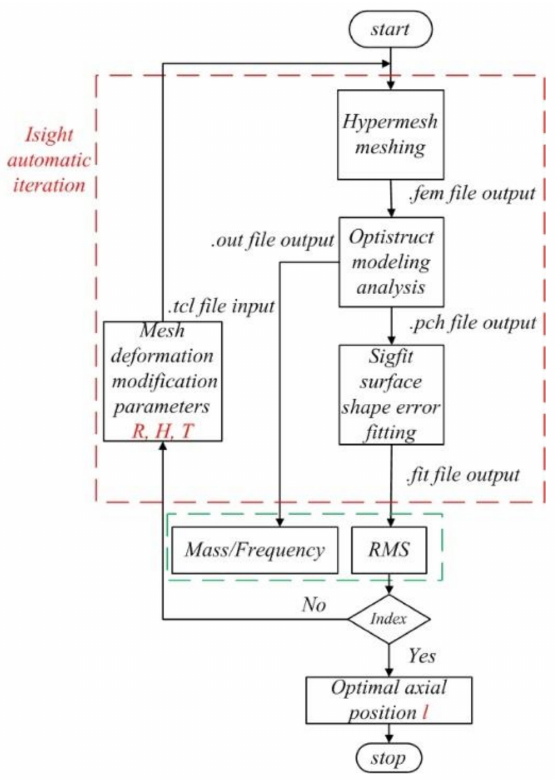
Figure 8. The flow of fast optimization. According to Equation (5), the multi-objective multi-island genetic algorithm (MIGA) is adopted to optimize the space mirror assembly. RMSt, RMSy, and RMS0.01 represent the RMS value of the mirror surface shape error under 4 ◦ C temperature change, lateral gravity, and 0.01 mm assembly error, respectively. A 0.01 mm assembly error indicates 0.01 mm of non-flatness on the flexible mounting surface. The radius of the flexure mounting surface is 37 mm, and non-flatness can reach 5 microns during traditional grinding, thus a certain margin is required, and we take 0.01 mm for the purposes of simulation. OPI is an optical performance index which represents the weighted value of the surface error under three working conditions. OPI and f1 are the objectives, while the RMS in three loads and mass are the